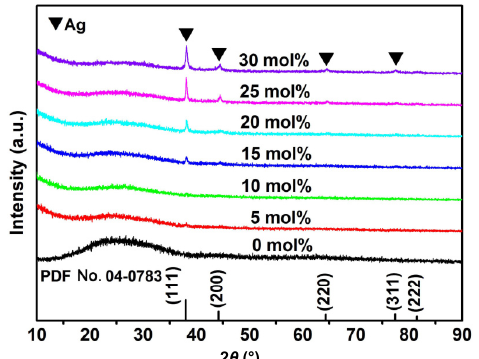
Fig. 1 XRD patterns of the Ag x /BTO thin films.